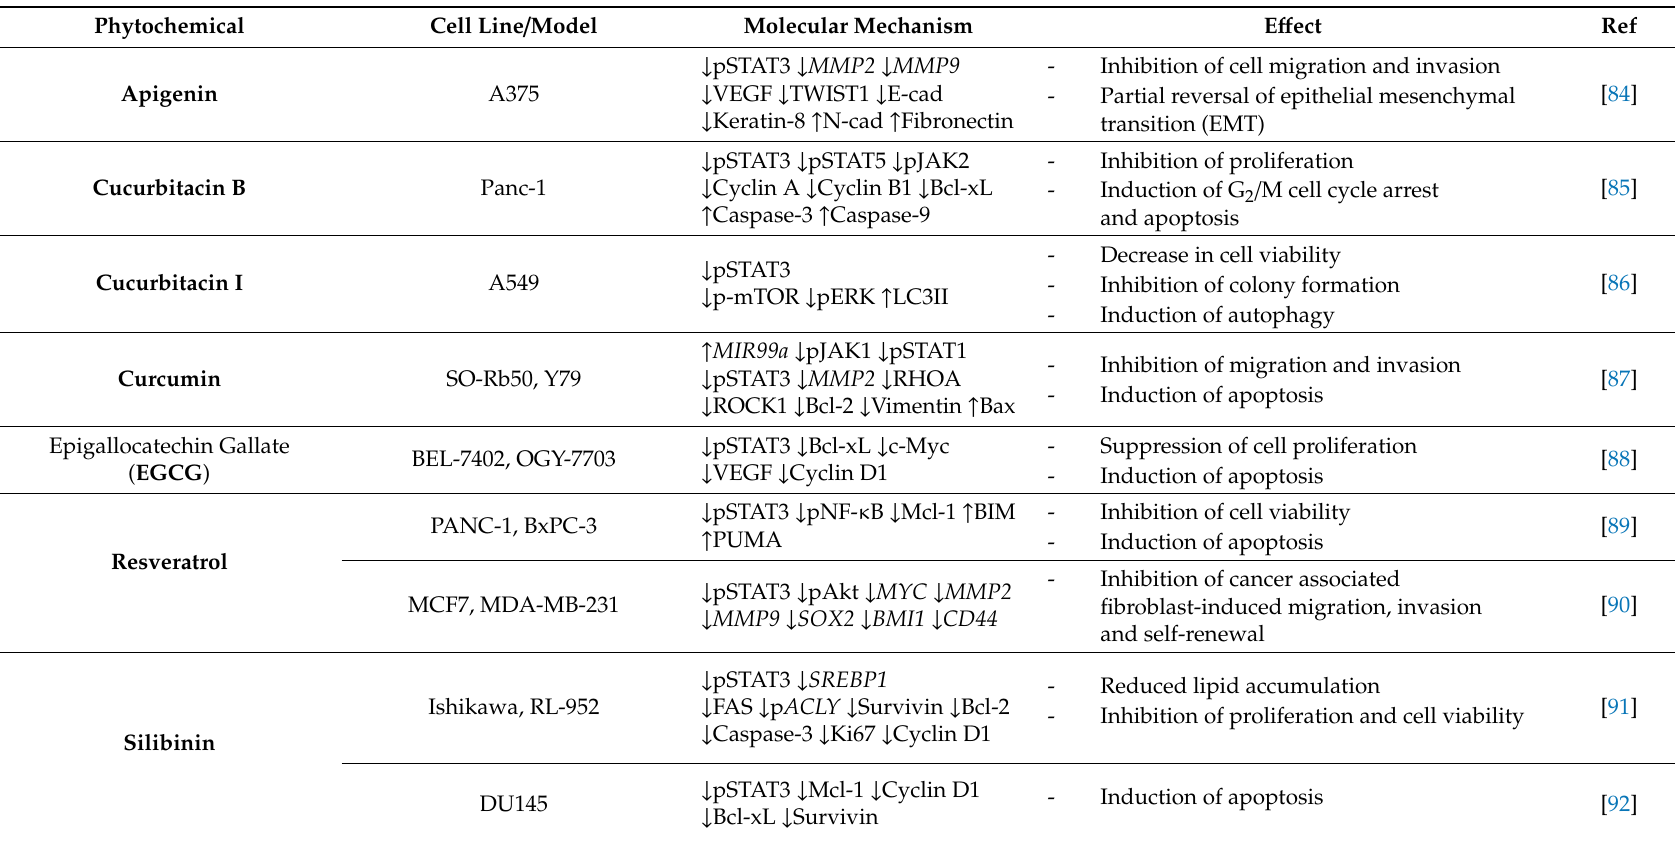
Table 1. E ff ects of the phytochemicals on STAT3 signalling and the targets in di ff erent cancer cell line